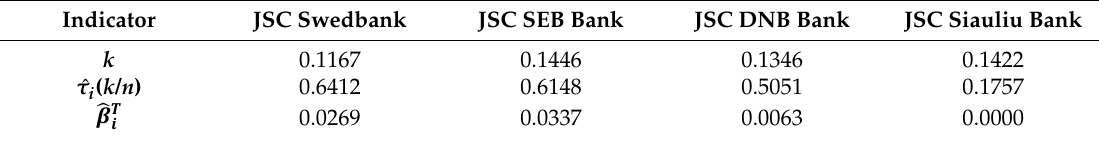
Table 4. The systemic risk assessment results.